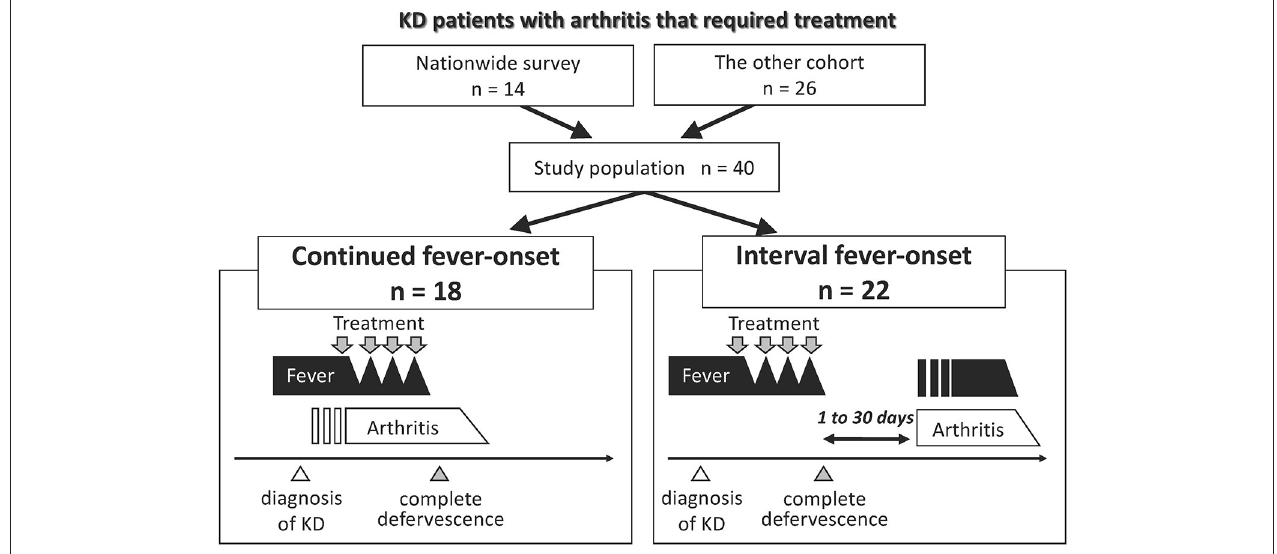
FIGURE 1 | Group classification of patients with KD-related arthritis. Fourteen and 26 patients who suffered from arthritis that required treatment until 30 days following the diagnosis of KD were extracted from the 23rd nationwide survey in Japan and the additional cohorts, respectively. We combined two cohorts and classified the patients into two groups according to the mode of onset of fever and arthritis. Open triangle represents the time of the diagnosis of KD. Gray triangle represents the time point of complete defervescence. Gray arrow indicates the point when patients received treatment for KD or